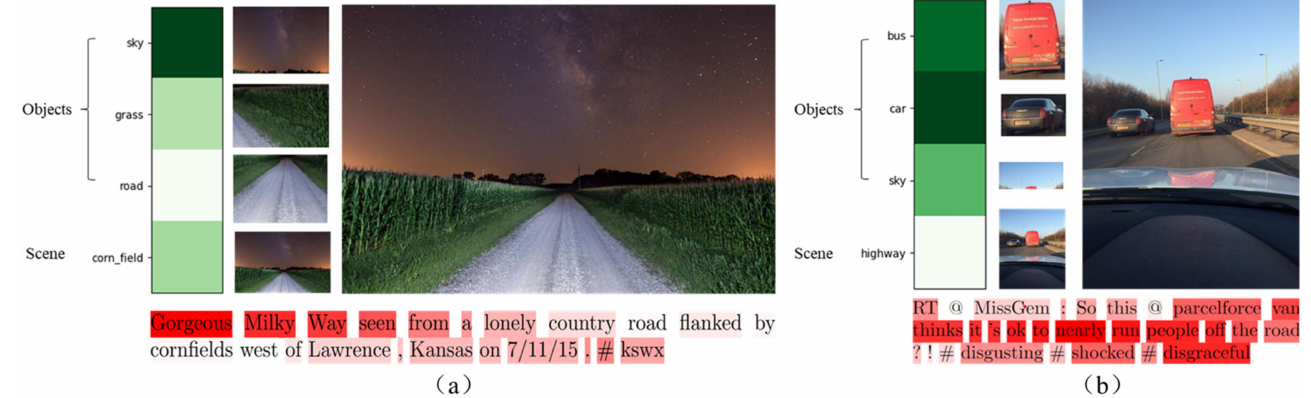
Figure 6. Visualization of the contribution of image region features and textual features for multi- modal sentiment analysis. ( a ) expresses a positive feeling, ( b ) shows a negative